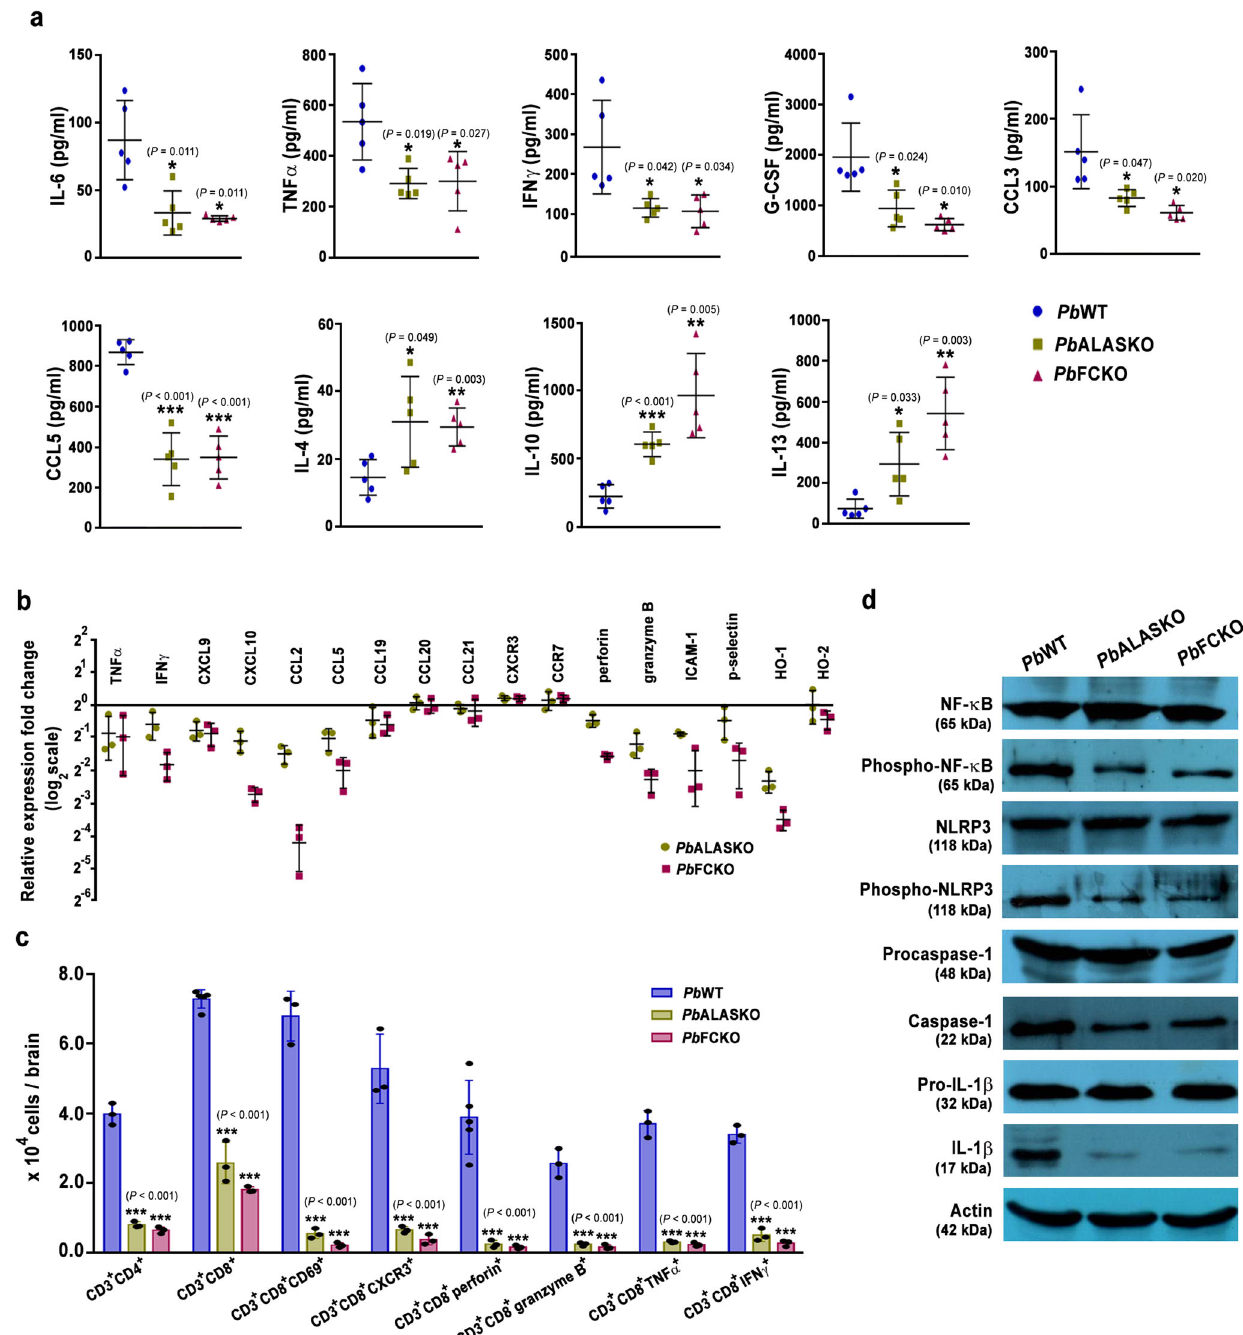
Fig. 4 Assessment of in fl ammatory parameters in heme pathway KO parasite-infected mice. a Plasma cytokine and chemokine levels of Pb WT- and Pb KO-infected mice ( n = 5) (mean ± SD; * P < 0.05, ** P < 0.01, *** P < 0.001, unpaired t -test; two-sided). b qPCR analyses of host transcripts in the brain samples of infected mice. Expression levels were normalized with mouse GAPDH. Relative expression fold changes of mRNA transcripts in the KO-infected mice with respect to WT-infected mice (mean± SD) are shown ( n = 3). c Flow cytometry analyses of T cells in the brain samples of infected mice. Mice on day 7/8 post-infection were used and the data for each cell type were obtained from at least three different mice infected with Pb WT or Pb KO parasites (mean ± SD; *** P < 0.001, Two-way ANOVA). Individual data points are shown as black circles. Gating strategy and representative fl ow cytometry plots are shown in the Supplementary Fig. 2. d Western analyses of brain homogenates prepared from Pb WT- and Pb KO-infected mice. 200 μ g of total protein was used from the pooled brain homogenates of three different mice for Pb WT, Pb ALASKO and Pb FCKO. n = 2 independent experiments. Full-length blots are provided in the Supplementary Fig. 7. Source data are provided as a Source Data fi le.